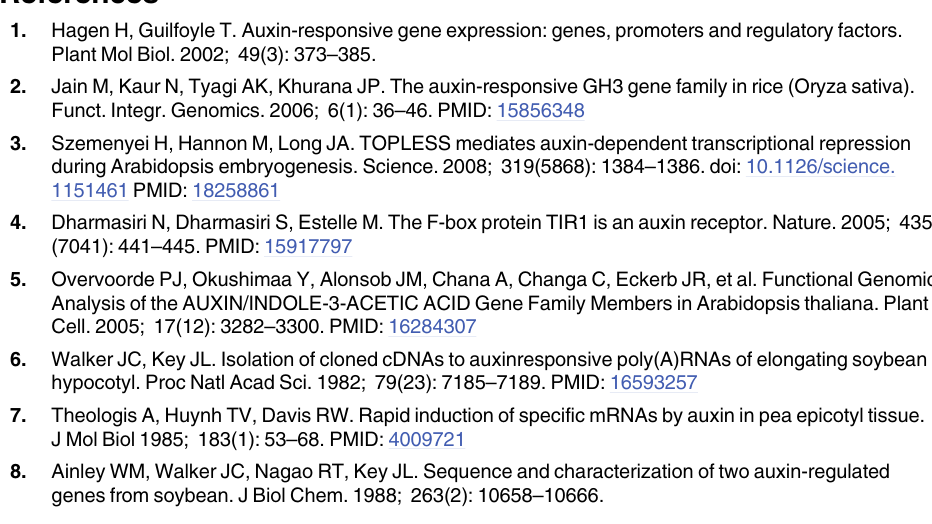
S4 Fig. Phylogenetics analysis and motif distribution of 55 BrIAA proteins. Phylogenetics tree was constructed by Neighbor-joining method with 1000 bootstrap replications and values were given on each node. Motifs for each protein were predicted by MEME web server and motif height in each gene symbolizes the conservation. S5 Fig. Semi qRT-PCR analysis of BrIAA30 and BrIAA31 in the different organs of ‘ Chiifu ’ and ‘ RcBr ’ . S1 Table. Primer information used for the semi qRT-PCR. S2 Table. Single Nucleotide Polymorphisms identified between Chiifu and RcBr lines along with the strand and block information. S3 Table. Synteny analysis between the BrIAA